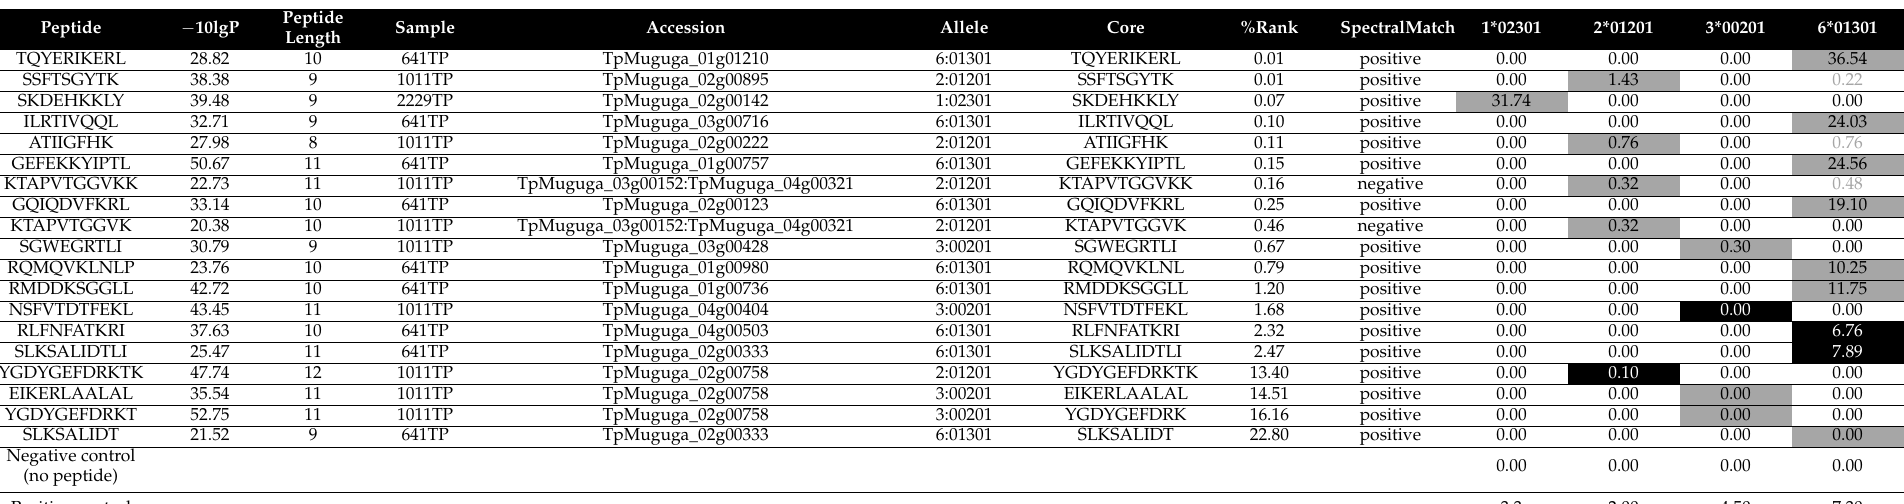
Table 2. Summary of in vitro determined peptide-MHCI dissociation rates (expressed as half-life of peptide-BoLA-I complexes at 37 ◦ C in hours) for a subset of peptides identified from 1011TP, 2229TP, and 641TP cell lines. The dissociation rate of each peptide binding to BoLA-I alleles 1*02301, 2*01201, 3*00201, and 6*01301 was assayed by a scintillation proximity assay, essentially as previously described (see Materials and Methods). Peptides that managed to form a complex BoLA-I molecule and for which a half-life could be measured were considered to be BoLA-I binders. Scores from the in vitro assay that corroborated the in silico predicted ability of peptides to bind to BoLA-I molecules expressed in the cell lines from which they were identified are highlighted with a dark grey background. Scores that are discrepant with the in silico predictions are highlighted with a black background in white script. Three peptides that bound to 6*01301 (BoLA-A18) but were identified from 1011Tp (BoLA-A10) are shown in light grey script. The scores of negative controls (no peptide) and positive control peptides are shown (no peptide) and positive control peptides are